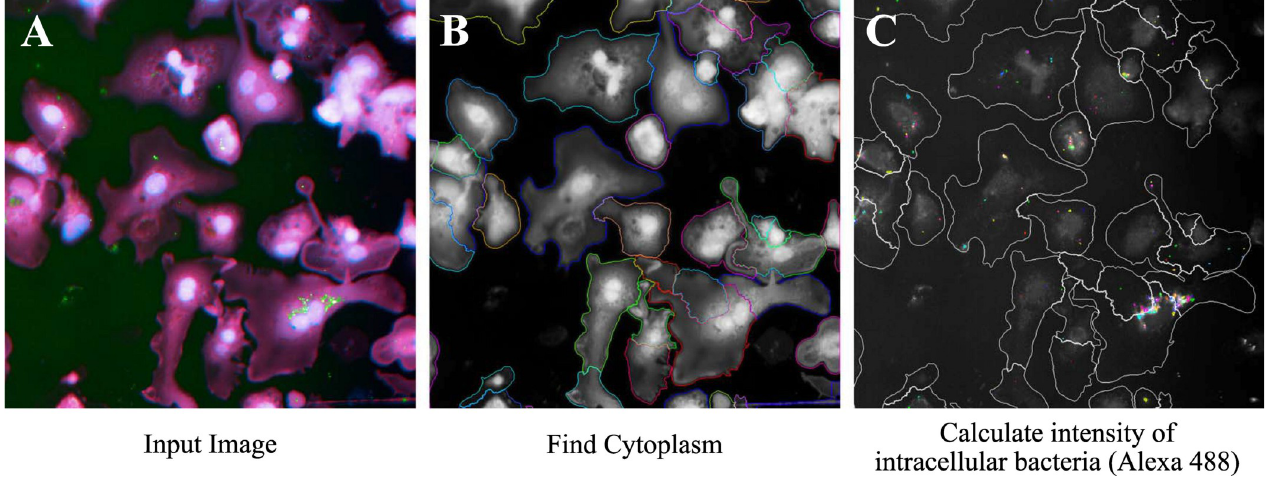
Fig 4. Workflow of Harmony software image analysis for intracellular M . ulcerans . THP-1 cell cytoplasm, nuclei, and bacterial immunostaining input image were shown in Fig 4A. Cytoplasm with nucleus were detected by HCS Cell Mask Deep Red and Hoechst 33258 channel respectively (Fig 4B). Bacterial cells were identified as Alexa 488-staining objects within cytoplasm were specifically detected, and calculated the intensity of them (Fig 4C).